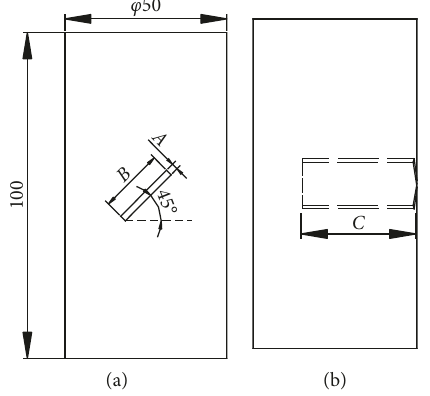
Figure 3: The schematic diagram of fissure. (a) Front view of specimen and (b) lateral view of specimen.